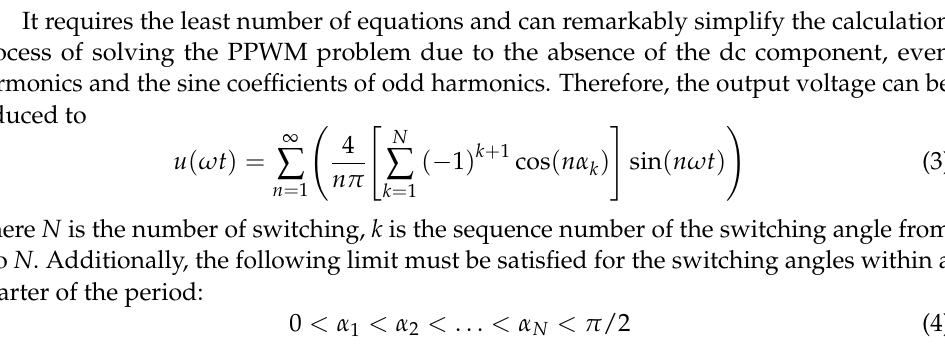
Figure 3. Three-level waveform with quarter-wave symmetry.